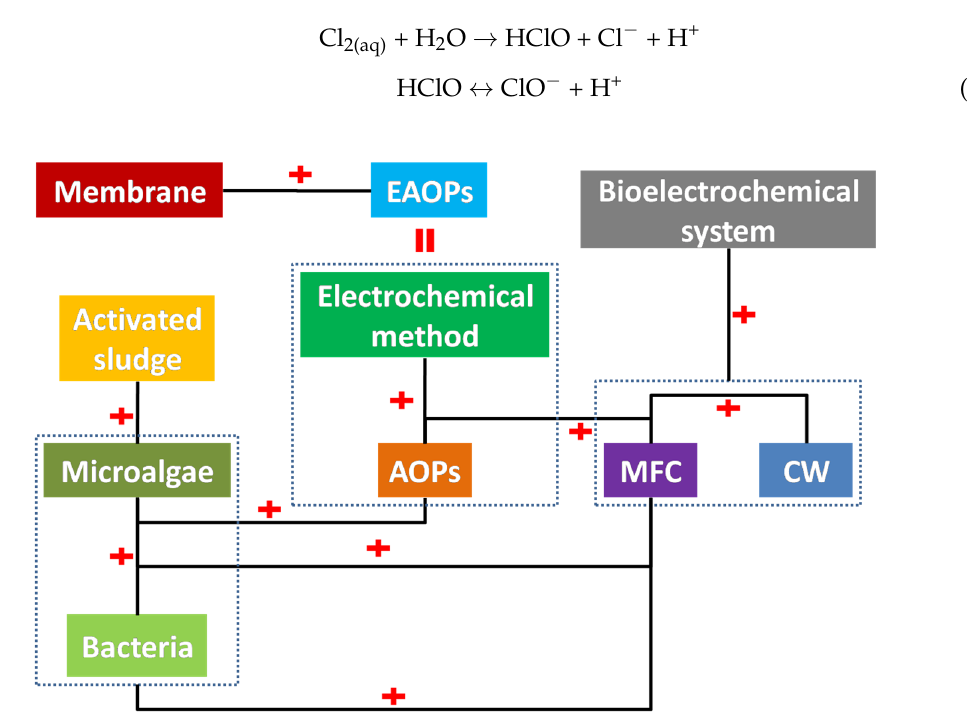
Figure 11. Hybrids of different techniques for antibiotic removal.